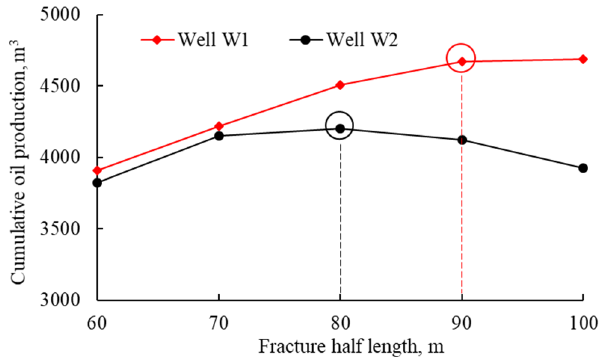
Figure 13. Fracture half-length optimization results.